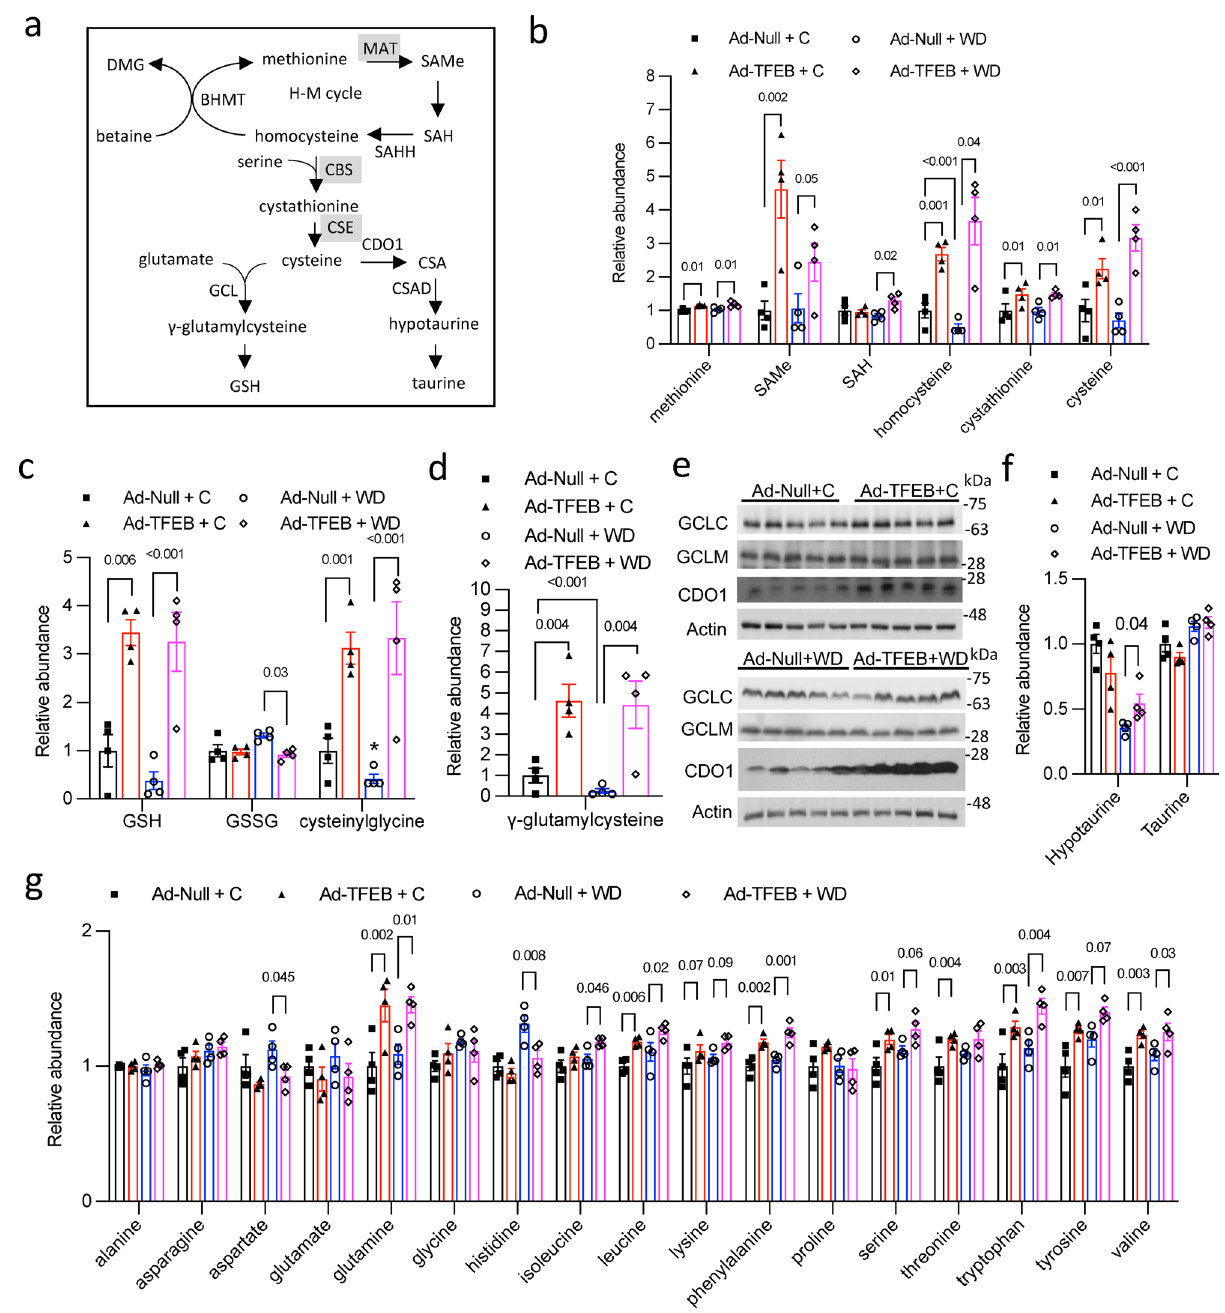
Fig. 2 | TFEB stimulates methionine cycle-transsulfuration to increase hepatic cysteine and GSH pool. a Illustration of methionine cycle-transsulfuration path- way and GSH and taurine synthesis. MAT1A Methionine adenosyltransferase 1A, CBS cystathionine β -synthase, CSE cystathionine γ lyase, SAMe S-adeno- sylmethionine, SAH S-adenosylhomocysteine, BHMT betaine-homocysteine S- methyltransferase, CDO1 cysteine dioxygenase 1, CSAD cysteine sul fi nic acid dec- arboxylase,GCLglutamatecysteineligase,GCLCglutamatecysteineligasecatalytic subunit, GCLM glutamate cysteine ligase modi fi er subunit, CSA cysteine sul fi